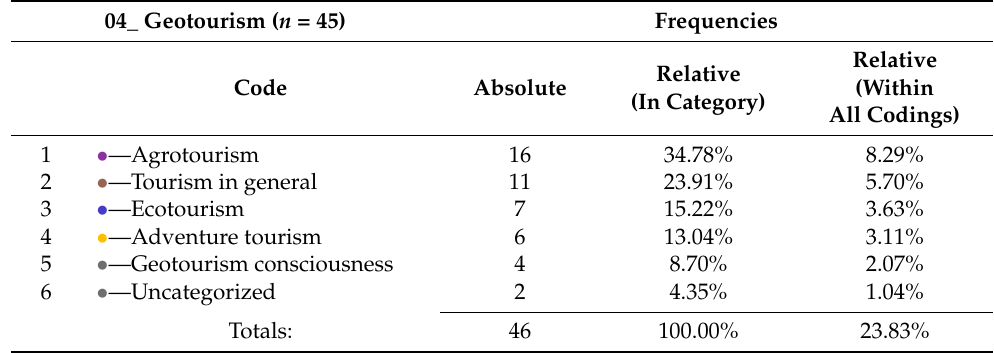
2 4.35% 1.04% Totals: 46 100.00%